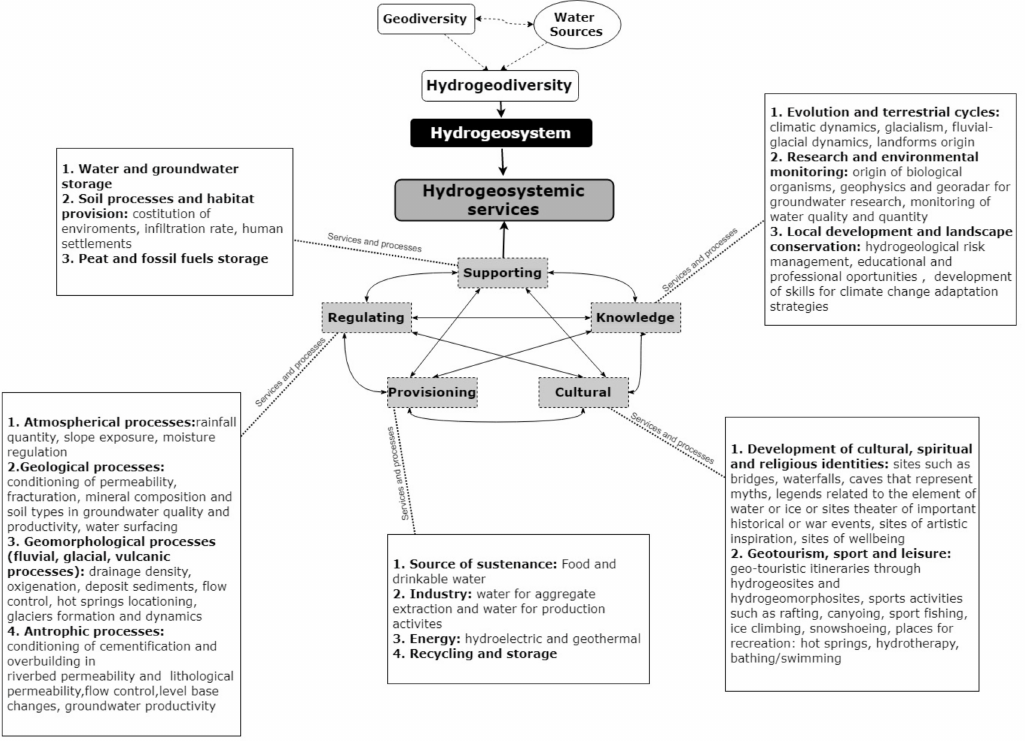
Figure 4. Hydrogeoservices from Gray (2013)